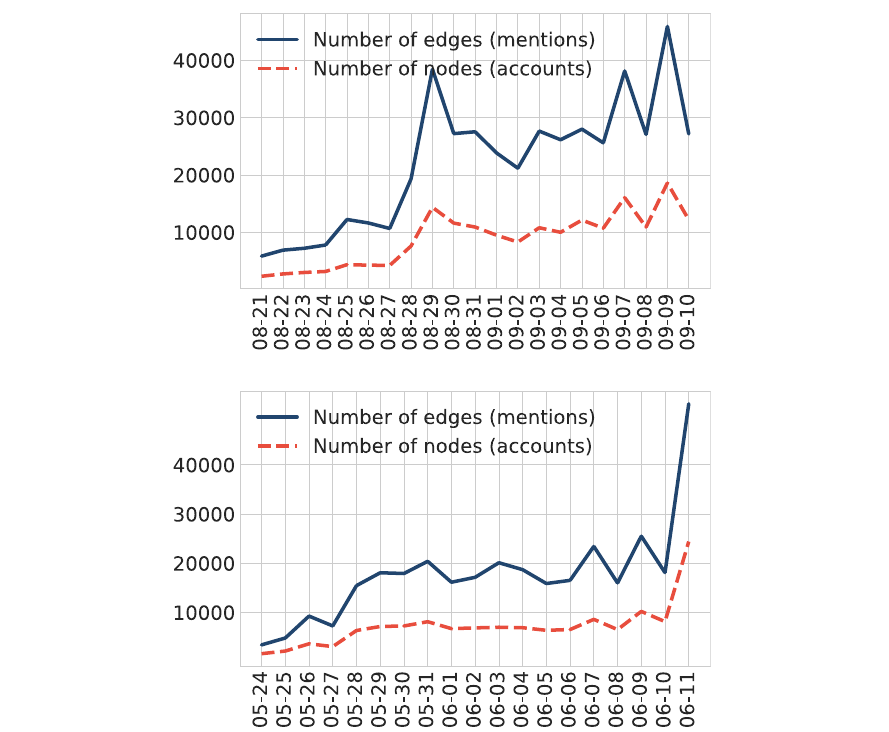
Fig. 6 Number of nodes and edges in the UO17 (top) and RG17 (bottom) mention graphs. During the qualifiers the number of interactions is low. Then user activity increases as the championship starts from Sept 28 or May 28 respectively. For UO17 the two bursts on September 7 and 9 are related to Women’s Singles semi-final and final. A similar behavior can be observed for RG17 due to Men’s Singles finals on June